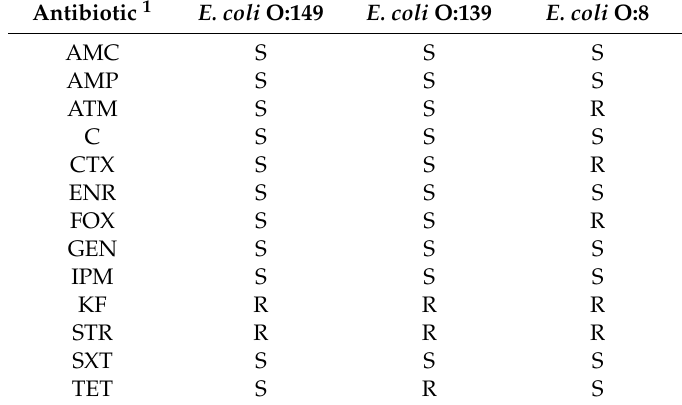
Table 1. Phenotypic antibiotic resistance profile of the three isolates according to EUCAST